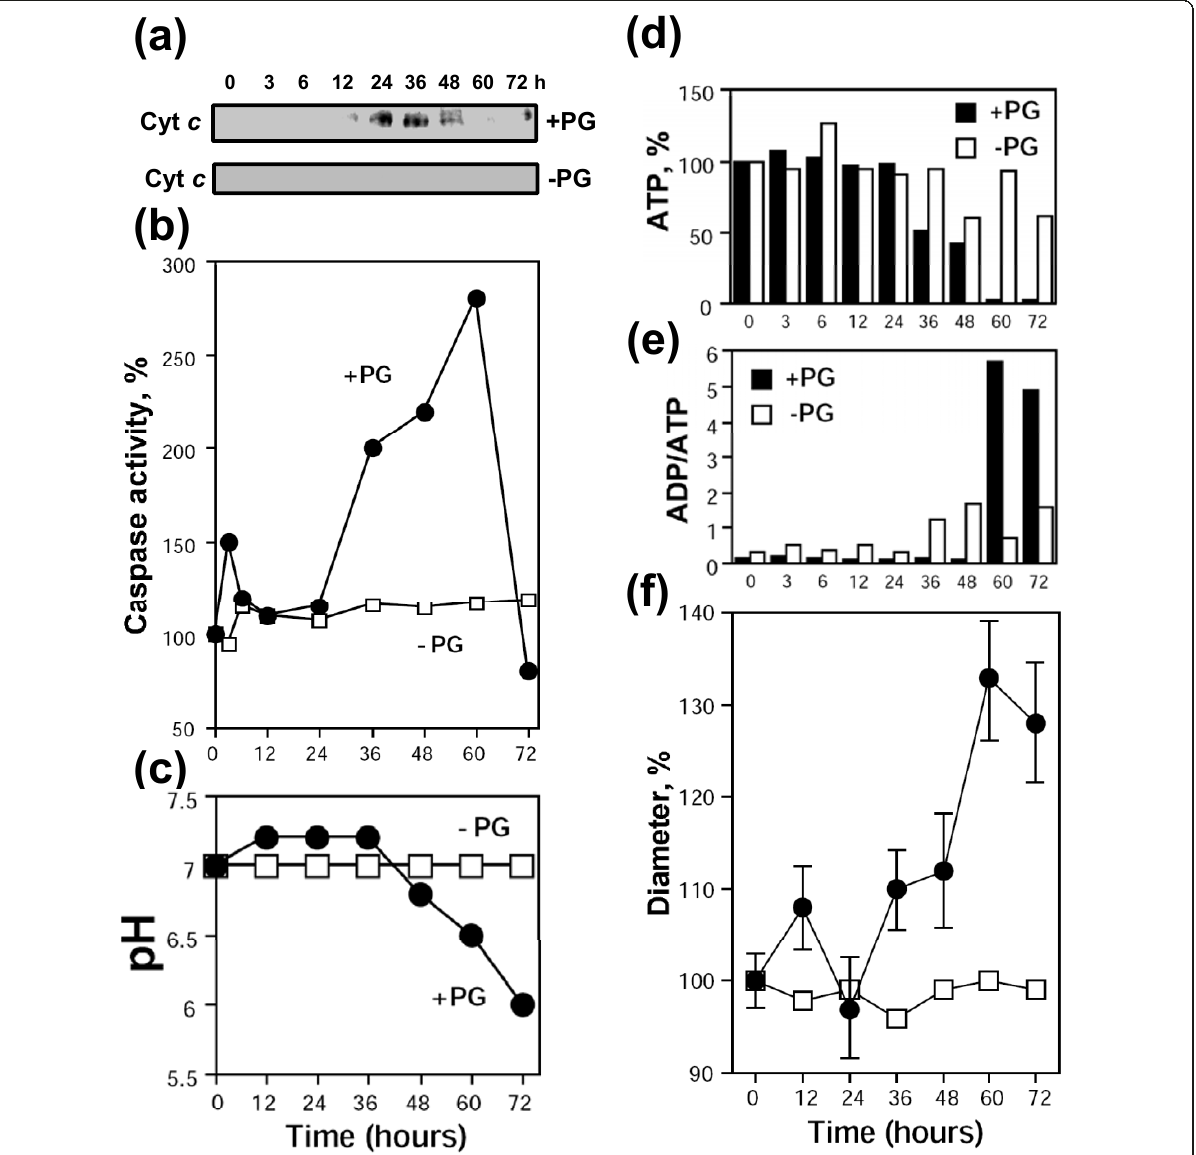
Figure 7 Apoptotic degradation of progesterone-treated Xenopus oocytes . Cytochrome c release (a) , caspase 3 activation (b) , intracellular pH (c) , intracellular ATP content (d) , ADP/ATP ratio (e) , and egg diameter (f) . Bars in panel (f) indicate SD of the mean obtained by measurement of five